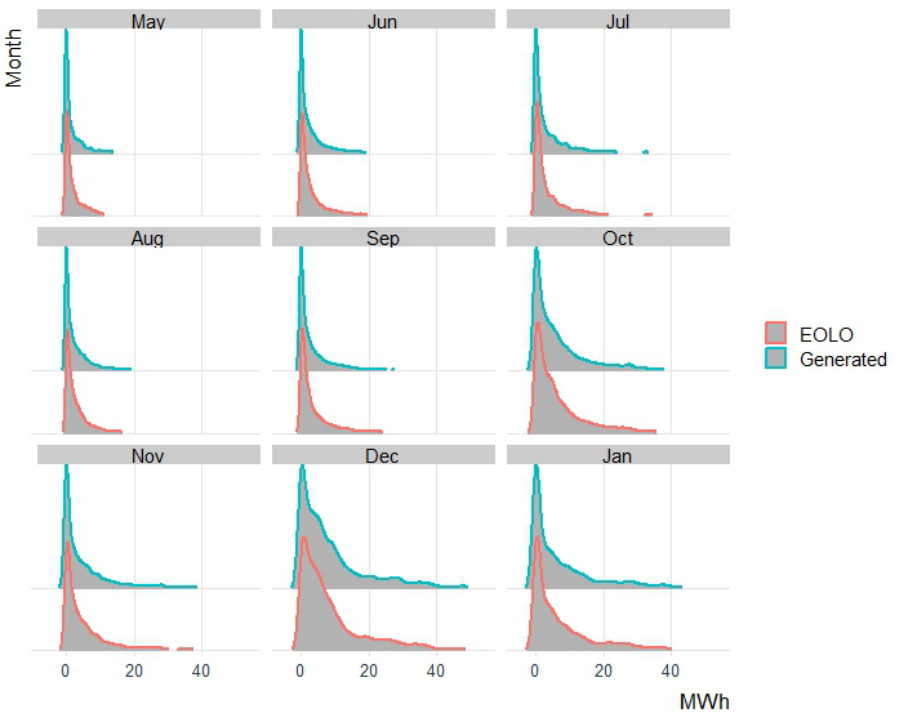
Figure 4. Hourly densities of power generated and predicted by EOLO (day-ahead